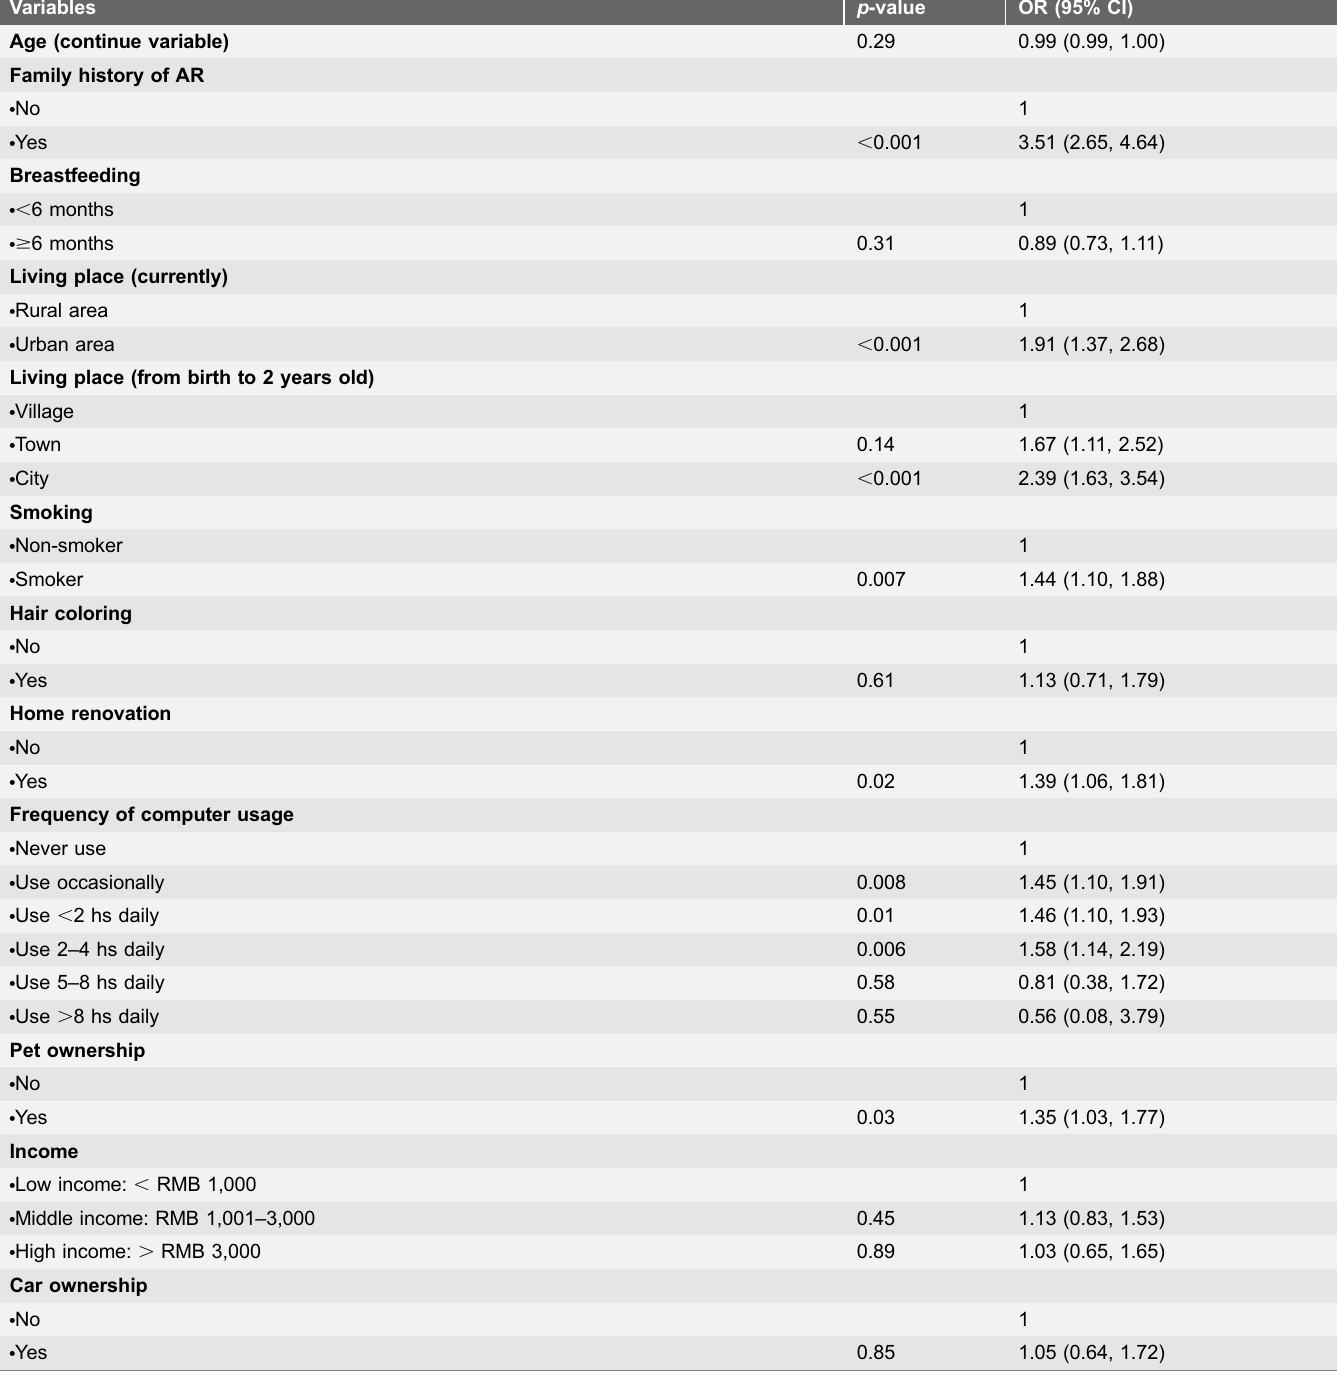
Table 1. Binary logistic regression of risk factors for